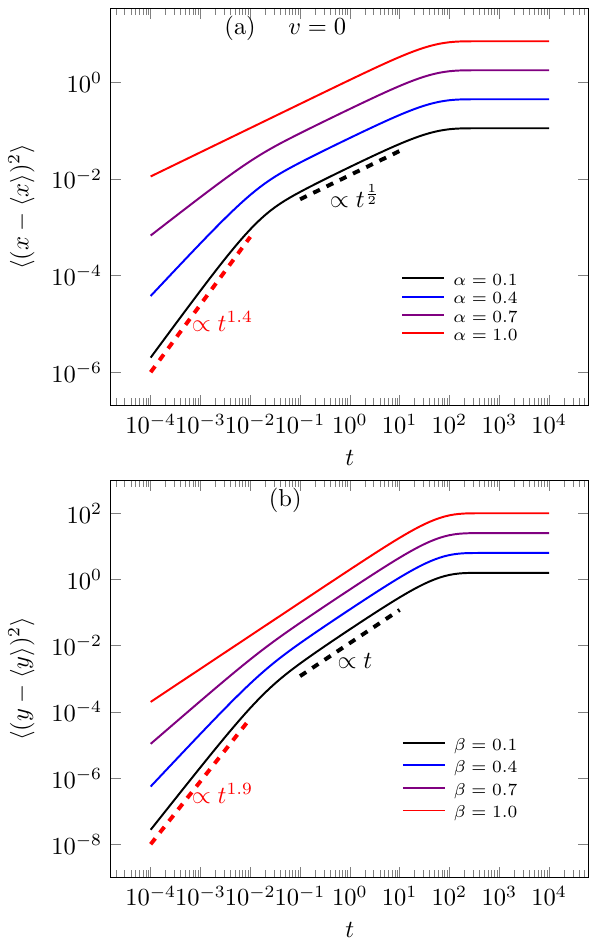
Figure 8. Figure ( a ) represents the MSD associated to Equation (35) for different α indexes with fixed β = 1. Figure ( b ) represents the MSD associated to Equation (36) for different β valuers. Both figures consider the parameter valuers as follows